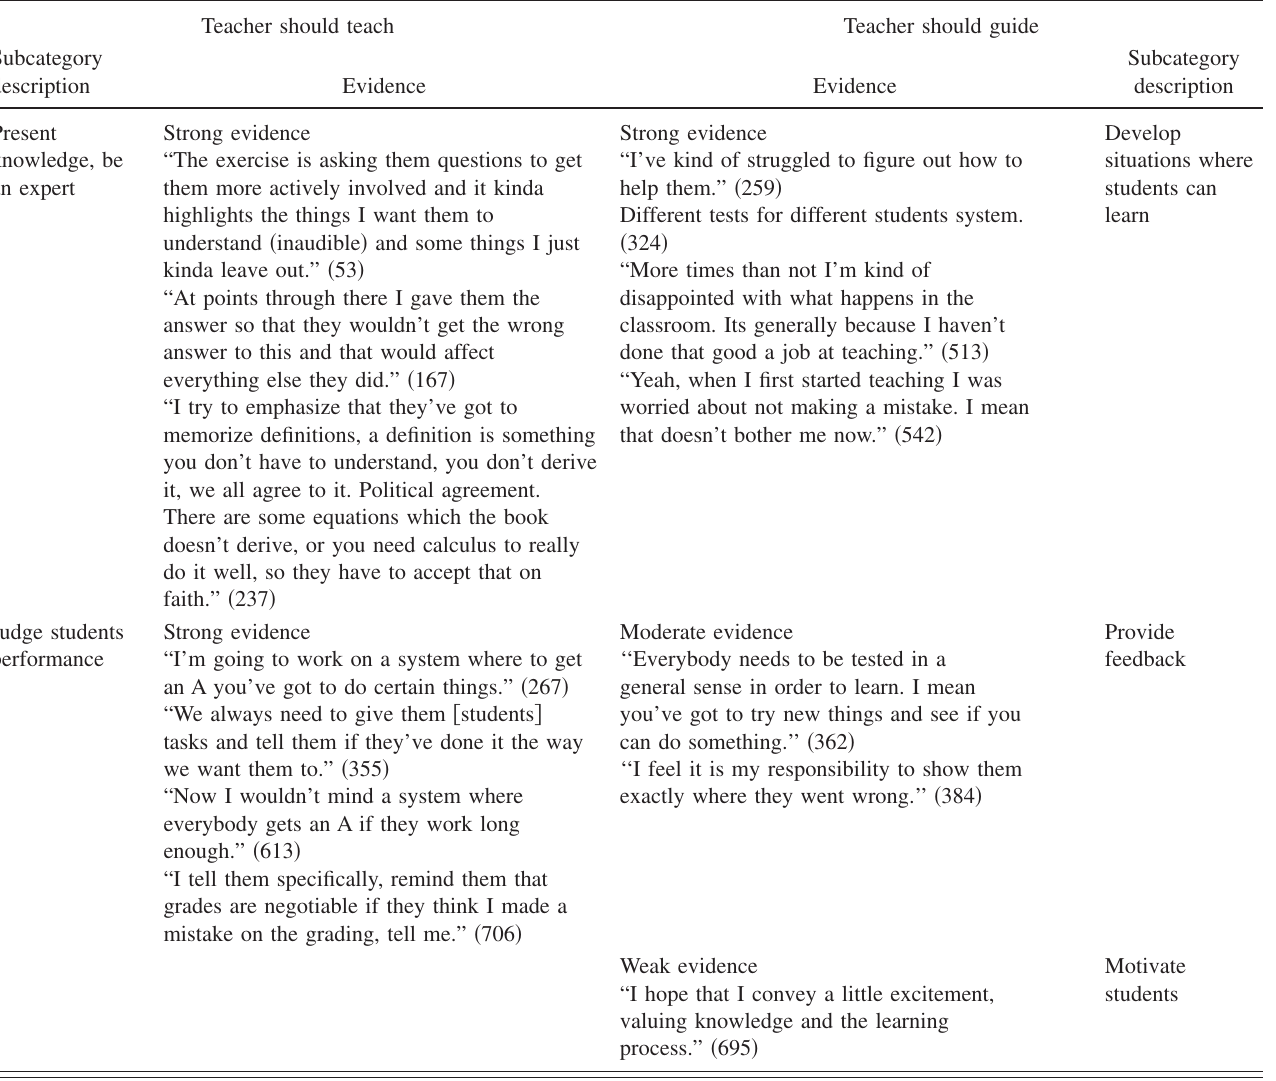
TABLE VI. (cid:1) Continued. (cid:2)